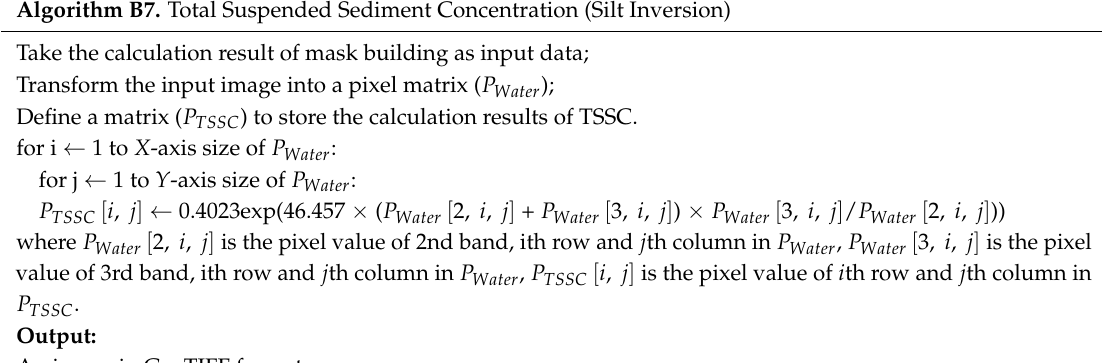
Algorithm B7. Total Suspended Sediment Concentration (Silt